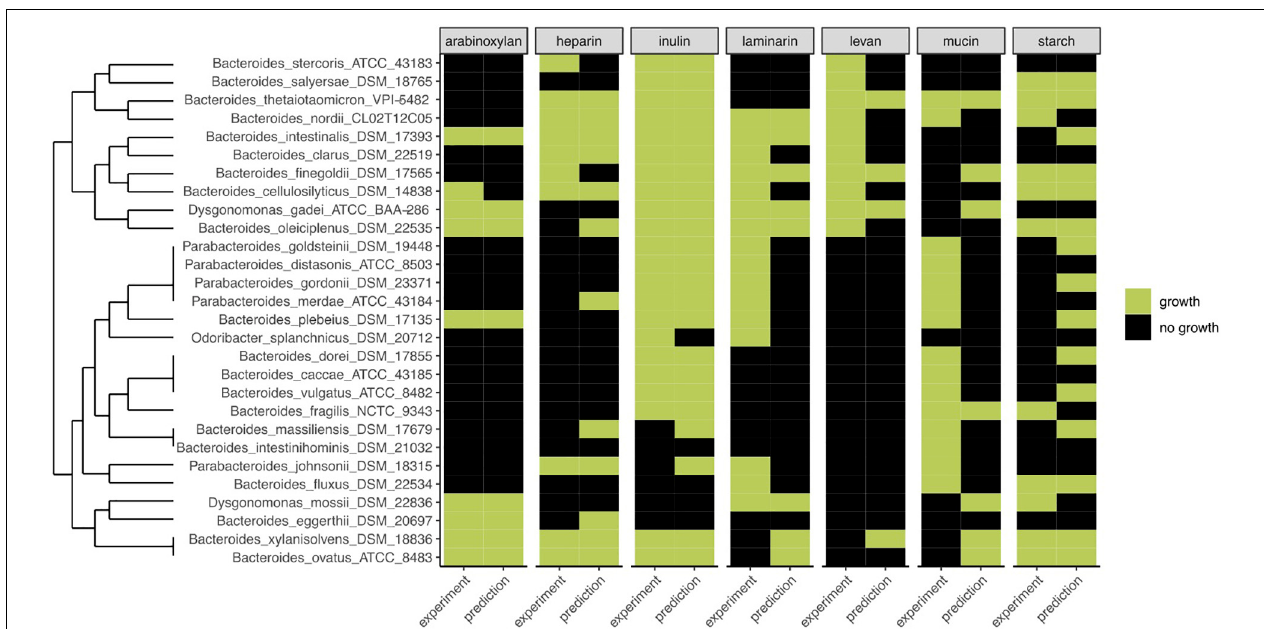
FIGURE 4 | Comparison of FiberGrowth PUL-based predictions with experimental growth data for 28 strains from the Bacteroidales family. For each strain, the prediction and experimental result of growth (green) or absence of growth (black) on different growth media are shown. Dendrogram is calculated on experimental growth results.